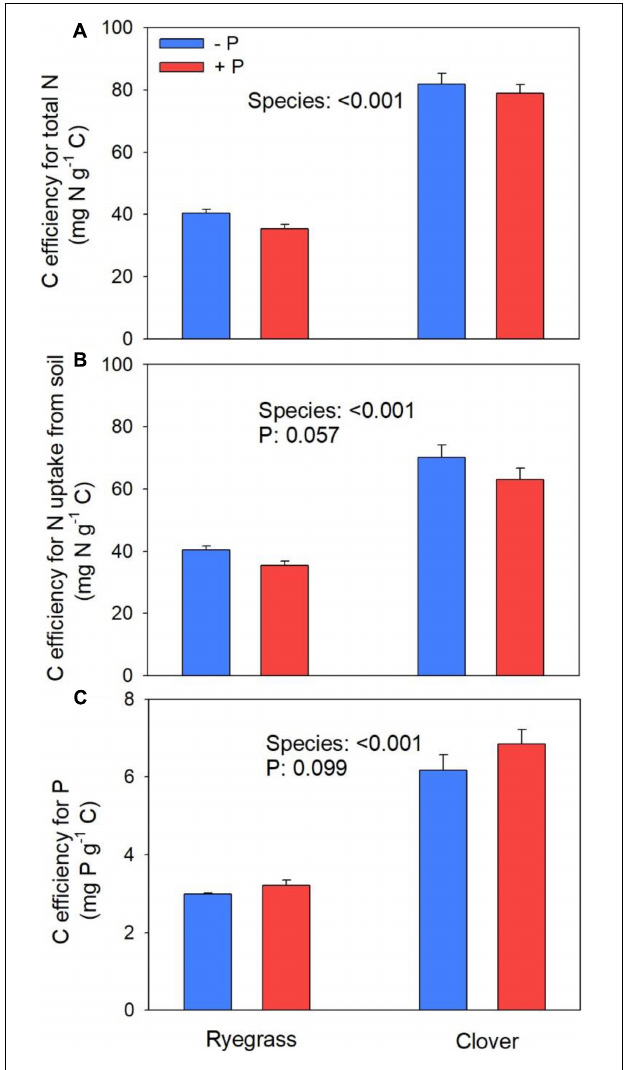
FIGURE 2 | Belowground C efficiency for N acquisition (CENA N ) including (A) and excluding (B) biological N 2 fixation and associated C allocation, and belowground C efficiency for P acquisition (CENA P ) excluding C used for biological N fixation (C) for ryegrass and clover with and without P addition. Sub-legend shows ANOVA p -values. Error bar indicates one standard error of the mean ( n = 4).